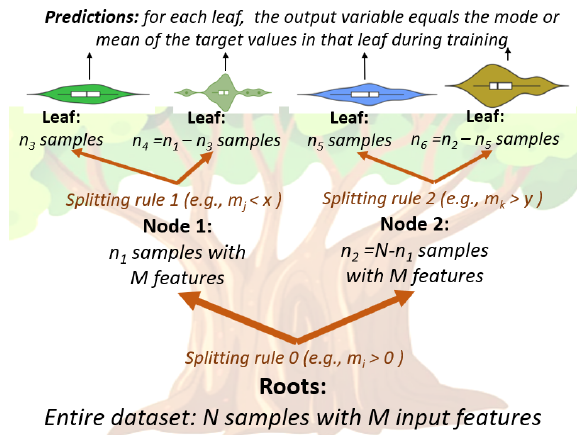
Figure 1. Example structure of a decision tree for a given dataset with N samples and M features, having seven nodes in total: one root node, two decision nodes, and four leaves, resulting in an over- all depth of three (i.e., longest path from roots to